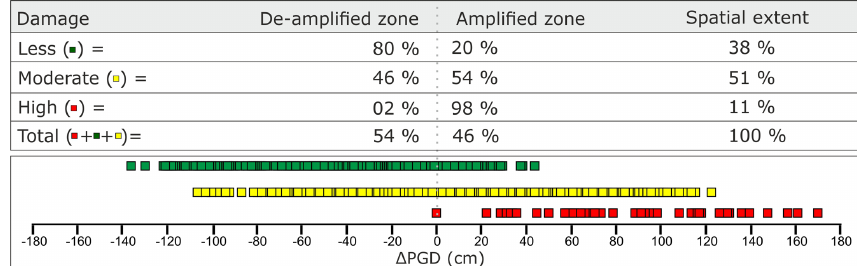
Figure 6. The difference in peak ground displacement ( (cid:49) PGD) between the models with and without topography (Fig. 4d) compared with damage data of Shafique et al. (2012). The top part shows the relation between damaged areas with (de-)amplification in table form. The bottom part shows the distribution of damage with (cid:49) PGD graphically. The high damage zone constitutes 11% of the Muzaffarabad damaged area, while moderate and low damage zones respectively cover 51% and 38% of the damaged area.